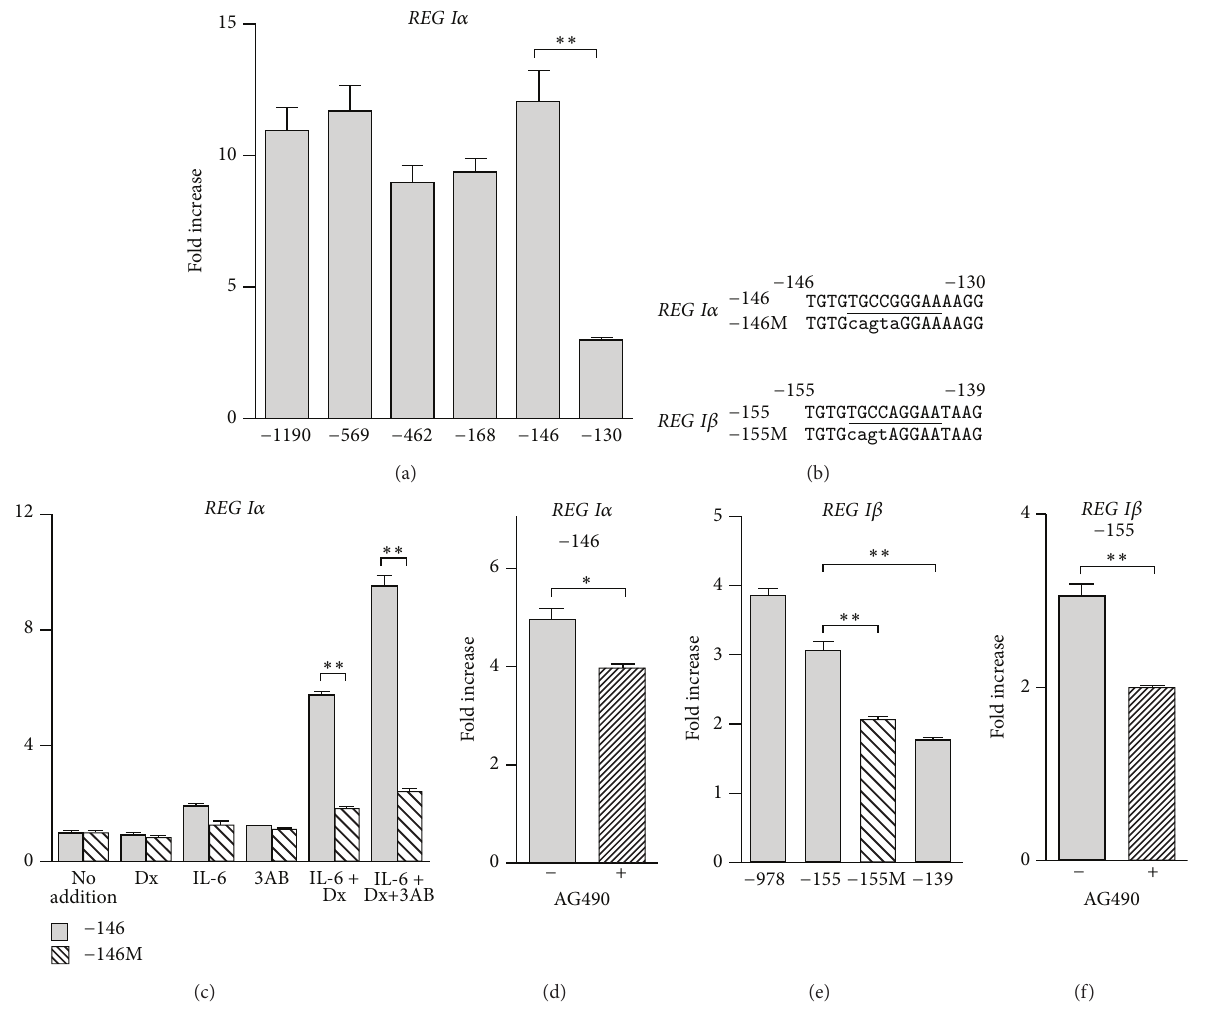
Figure 4: IL-6 + Dx-induced transcription of REG I 𝛼 and REG I 𝛽 in human 1.1B4 𝛽 cells is dependent on the JAK/STAT pathway. (a) IL-6 + Dx-induced REG I 𝛼 promoter activation in 1.1B4 cells. (b) Sequences of the human REG I 𝛼 and REG I 𝛽 promoters. Putative STAT-binding site is underlined. Nucleotide substitutions in the STAT-binding site are indicated by lower-case letters. (c) Effects of site-directed mutation on IL-6 + Dx-induced REG I 𝛼 promoter activation. (d) Effects of AG490, a JAK inhibitor, on IL-6 + Dx-induced REG I 𝛼 promoter activity. 1.1B4 cells were transfected with indicated construct. (e) IL-6 + Dx-induced REG I 𝛽 promoter activation in deleted and mutated promoter.